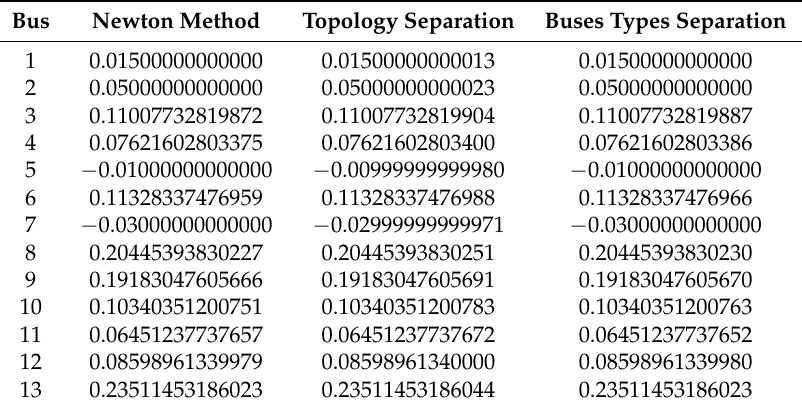
Table 7. Comparison of bus voltages’ drop